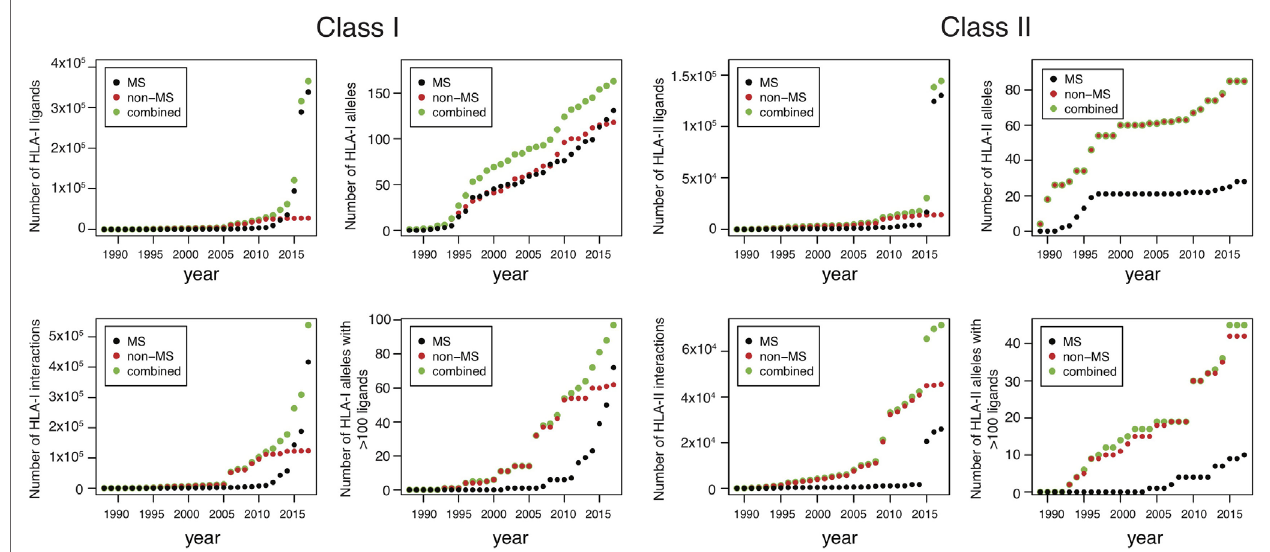
FiGURe 1 | Analysis of HLA-I and HLA-II ligands obtained from human leukocyte antigen (HLA) peptidomics studies and in vitro assays. The number of unique HLA-I ligands, the number of unique interactions, the number of HLA alleles with at least one ligand, and the number of HLA alleles with at least 100 ligands are displayed for both class I and class II, as a function of years (cumulative